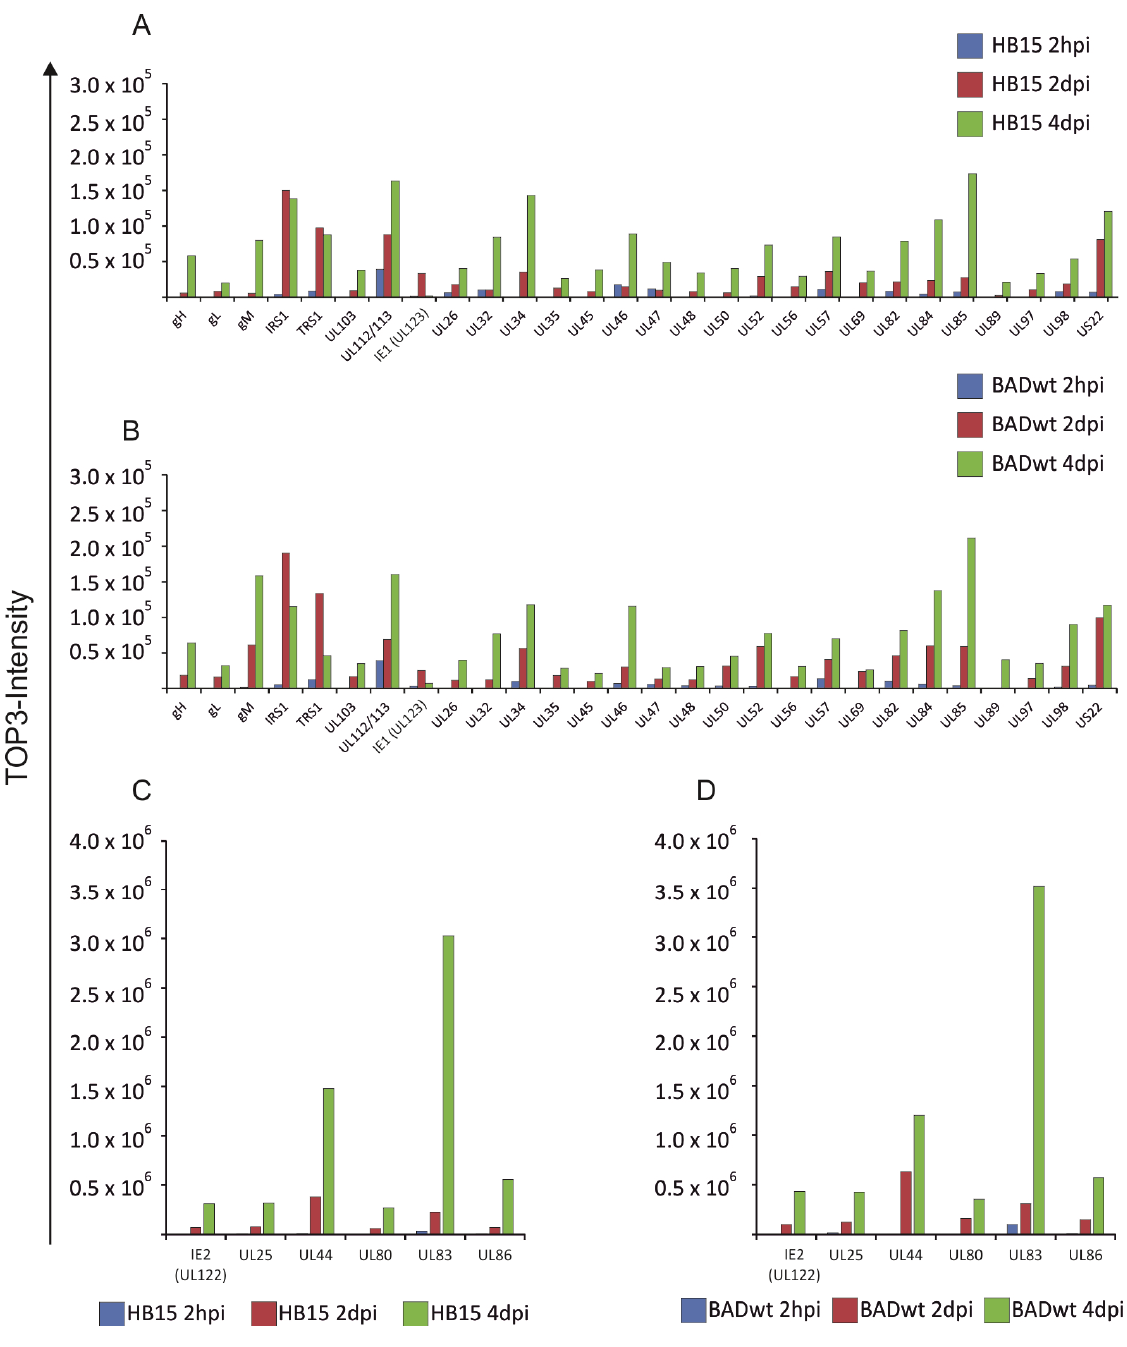
Figure 2. Time course of viral protein levels in infected HFF. The data shown in the pie charts in Figure 1 are displayed in bar chart format to show the course for each individual protein. ( A ) and ( C ), viral proteins in RV-HB15 infected cells. ( B ) and ( D ), viral proteins in RV-BADwt infected cells. Note that the scales are different in ( A ) and ( B ) versus ( C ) and ( D ). TOP3-intensity was calculated as the average intensity of three best ionizing peptides and is proportional to the molar amount of the respective protein in the